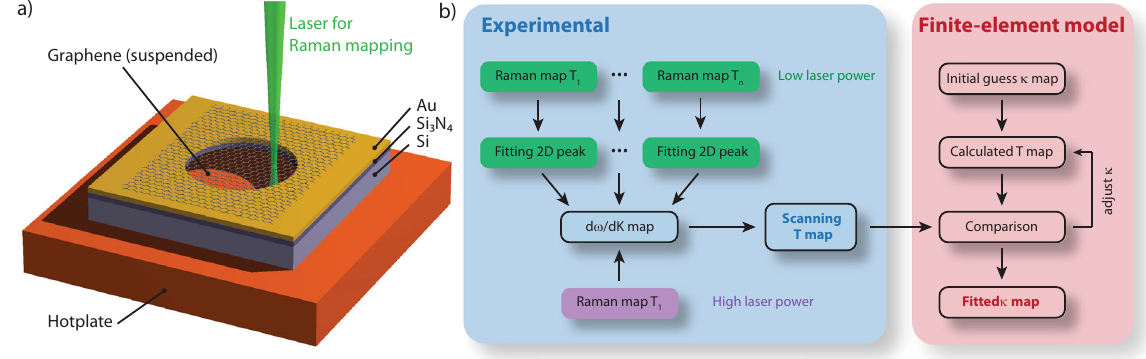
Fig. 1 Experimental and fi nite-element method description. a Schematic drawing of the suspended graphene membrane. b Experimental work fl ow to obtain a temperature map upon laser illumination and computational work fl ow to fi t the corresponding thermal conductivity